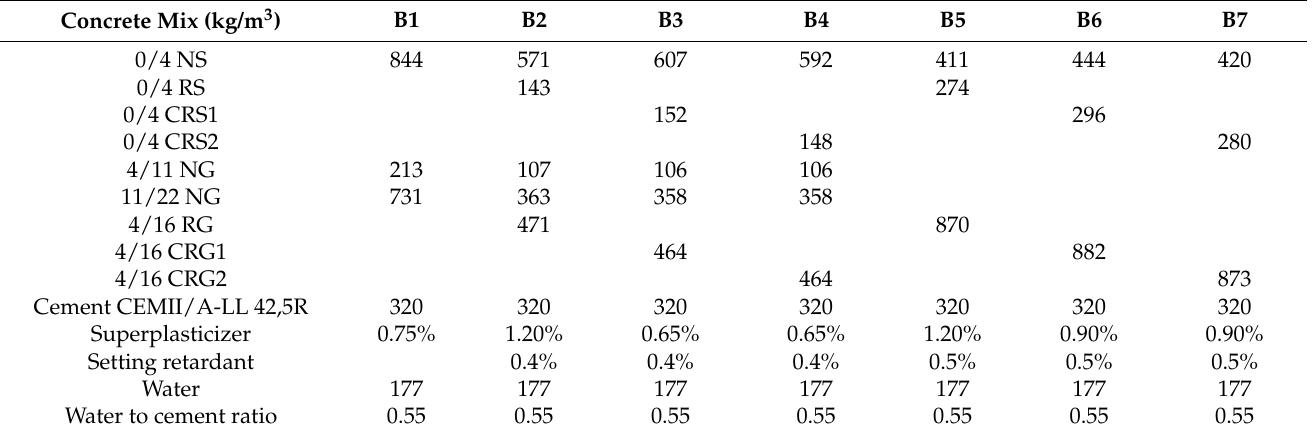
Table 4. Composition of the 7 C25 concretes (mass proportions).